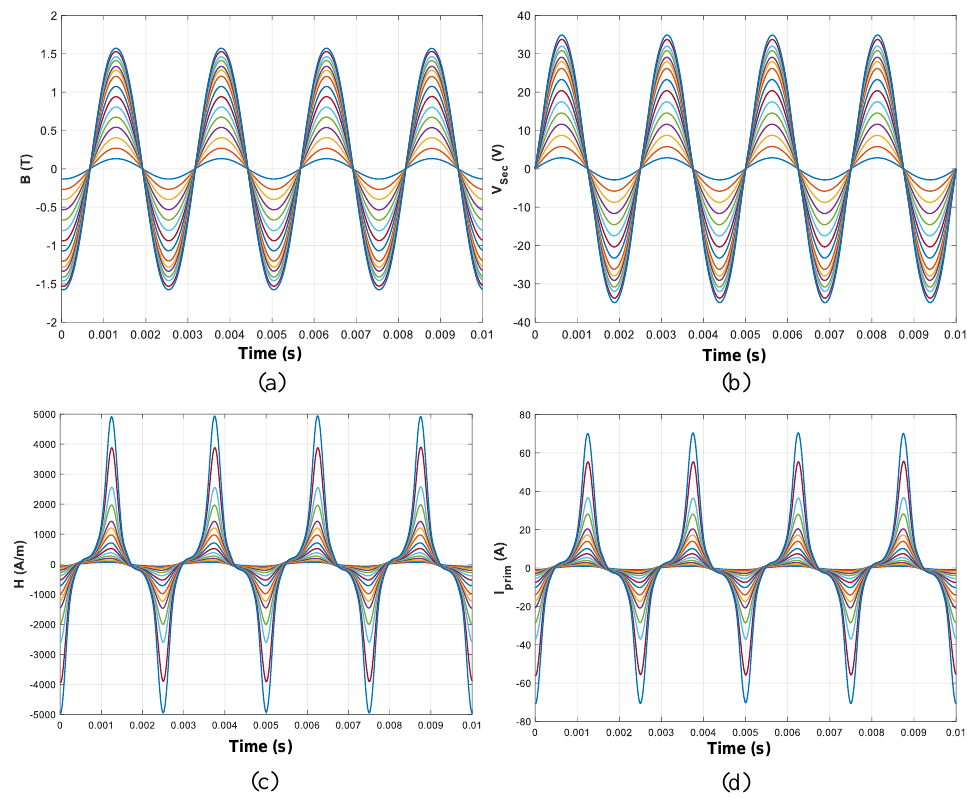
Figure 8. Measured B ( t ) and H ( t ) waveforms for a complete stator at different excitation levels at 400 Hz. ( a ) Magnetic flux density 0.1 T − 1.6 T. ( b ) Secondary voltage. ( c ) Magnetic field strength. ( d ) Primary current.